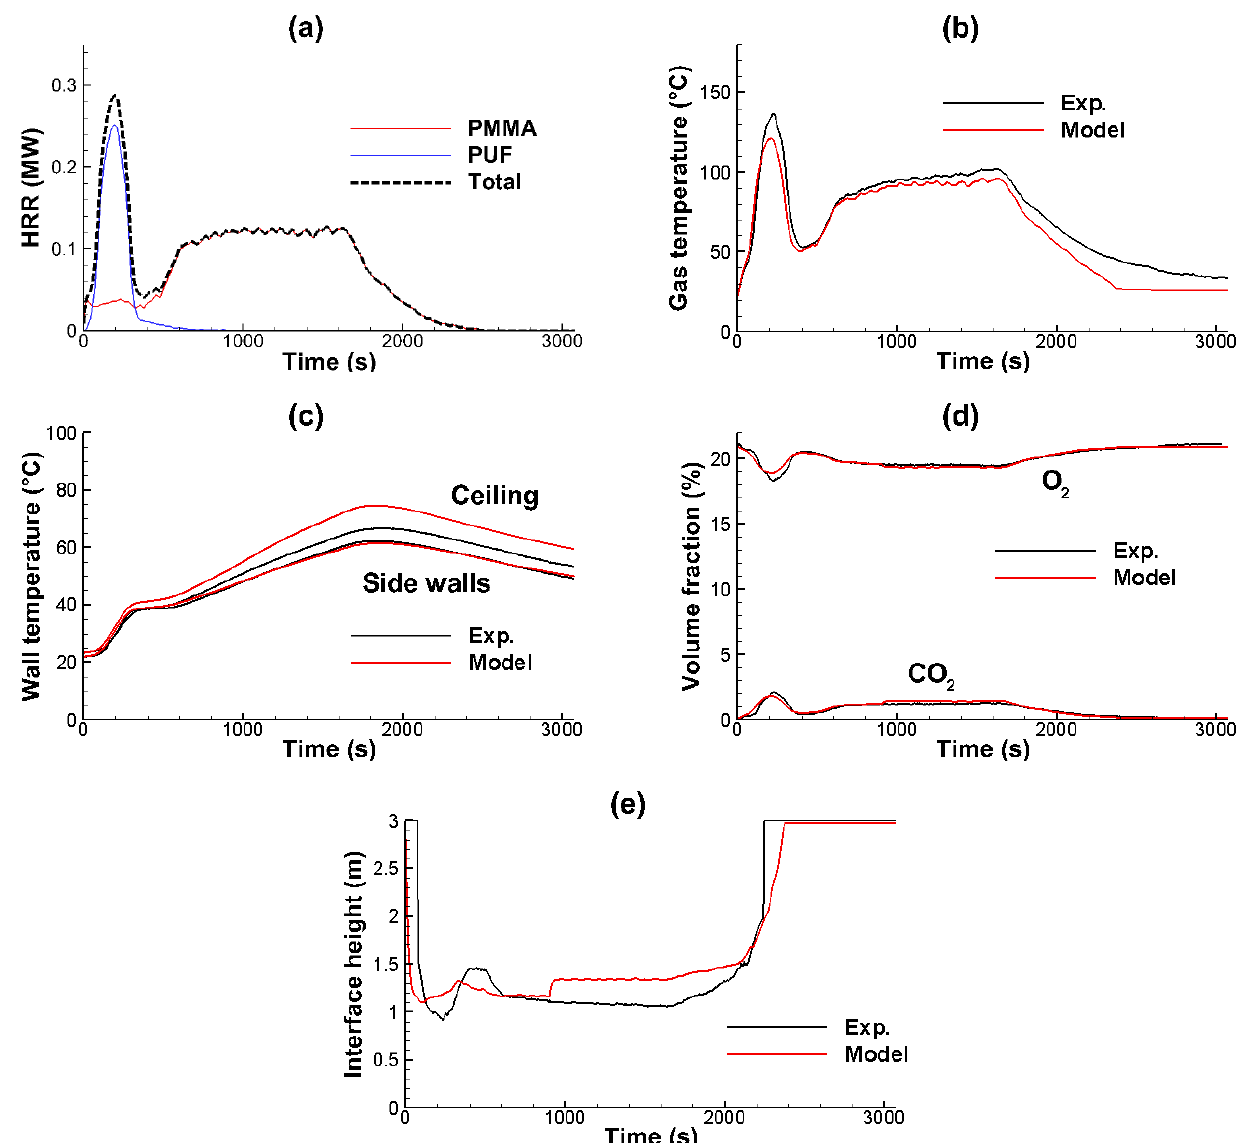
Figure 15. Test 7: ( a ) individual and total HRRs, ( b ) average gas temperature, ( c ) average wall temperatures, ( d ) volume fractions of O 2 and CO 2 in the exhausted gases, and ( e ) smoke layer interface height.